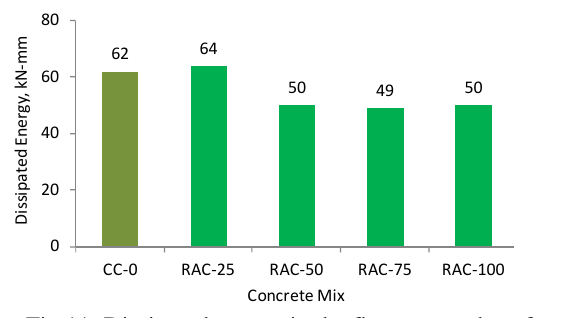
Fig.11: Dissipated energy in the first two cycles of 4mm amplitude